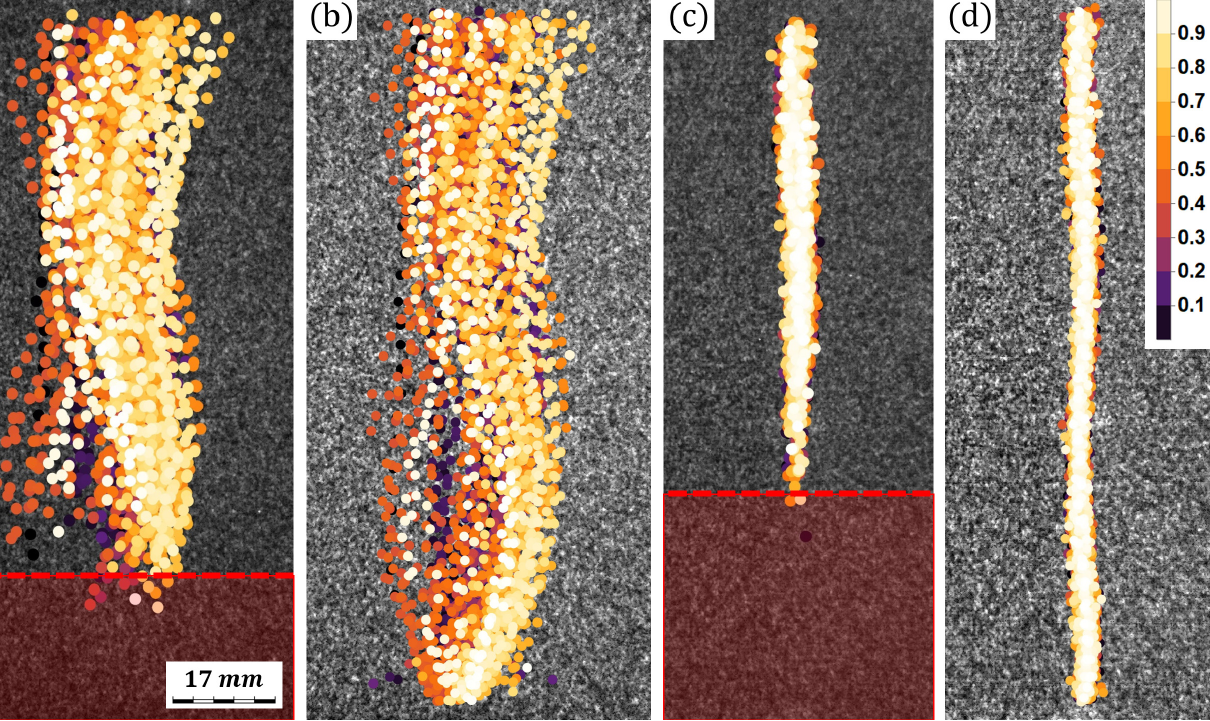
Figure 14. The locations of bubbles detected in the FOV for a sequence of 3000 images (30 s) at a 100 sccm flow rate for the model system from [8,43] (Section 2.1, horizontal inlet): no applied MF, ( a ) previous and ( b ) current image processing code; applied ∼ 265 mT horizontal MF, ( c ) previous and ( d ) current image processing code. Bubble locations are marked with dots color-coded in the chronological order of appearance. Note the color legend in ( d ): imaging starts at 0 and ends at 1. The red-tinted areas indicate the blind zones of the previously used image processing code. All sub-figures are to